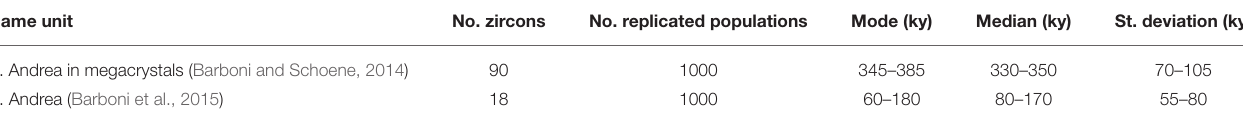
TABLE 2 | Values obtained by the bootstrapping of the zircon age popualtions of Barboni et al. (2015). Name